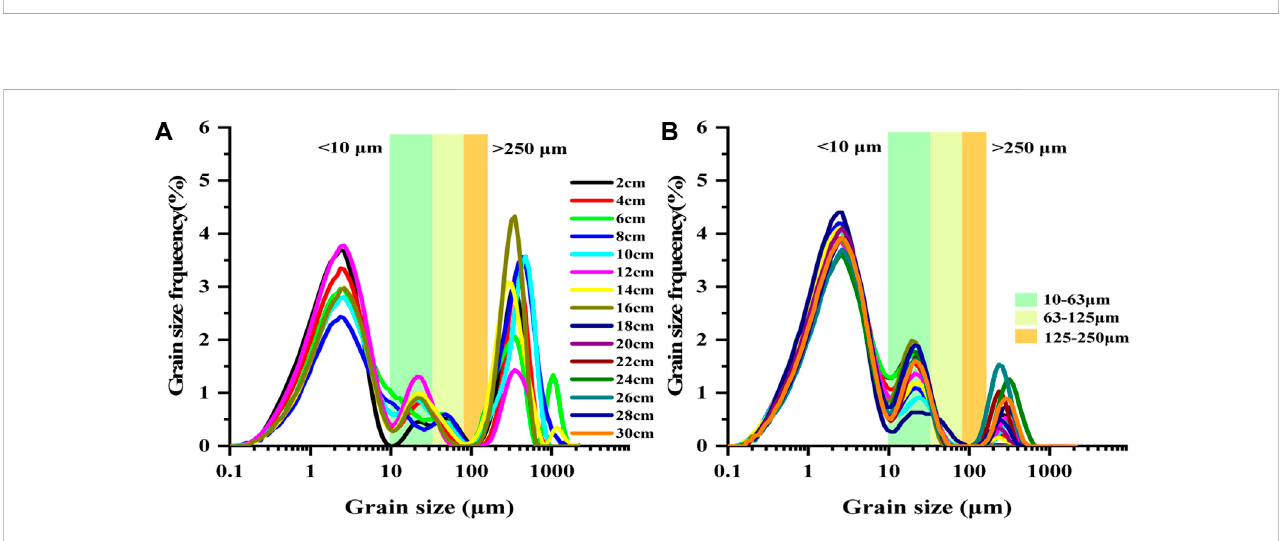
FIGURE 4 Horizontal sediment fl ux at different heights, (B) The squares represent salt dust emissions from the intermittently surface at wind speeds and the triangles represent salt dust emissions at fi ve wind speeds.